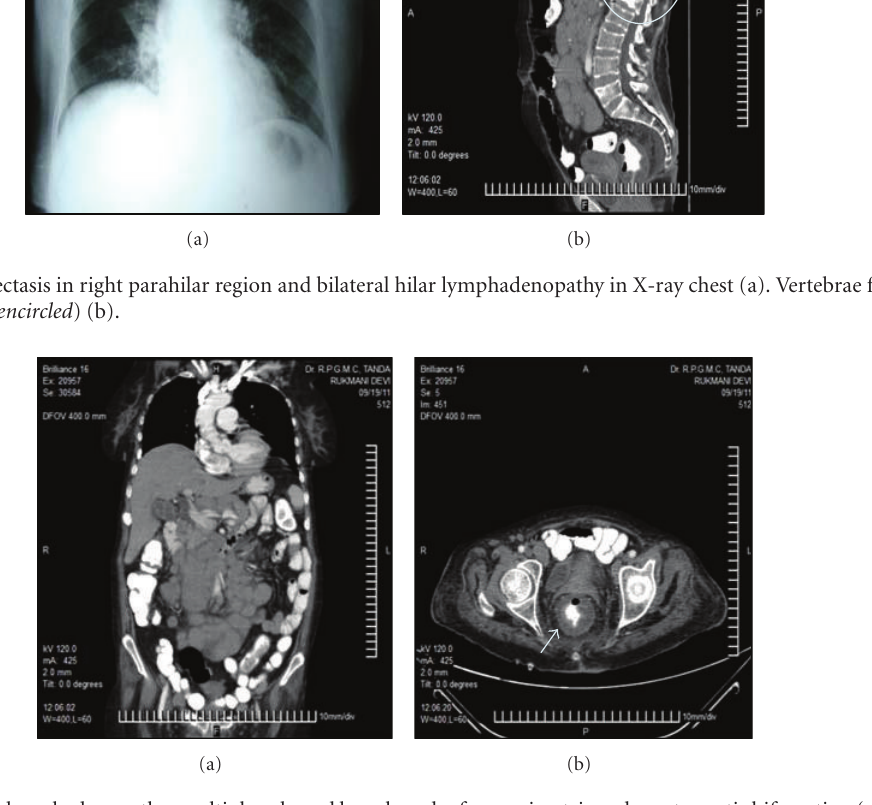
Figure 7: Retroperitoneal lymphadenopathy: multiple enlarged lymph nodes from epigastrium down to aortic bifurcation (a), and thickened sigmoidorectal wall ( arrow ) (b) in CT scan of